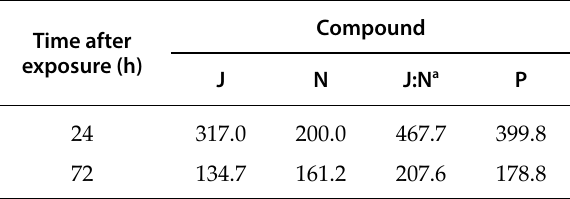
Table 1. Estimated values of lethal concentrations (ppm) necessary to give 50% mortality (LC 50 ) of Pratylenchus thor- nei mixed stages at 24 or 72 h after exposure to juglone (J), 1,4-naphthoquinone (N) or plumbagin